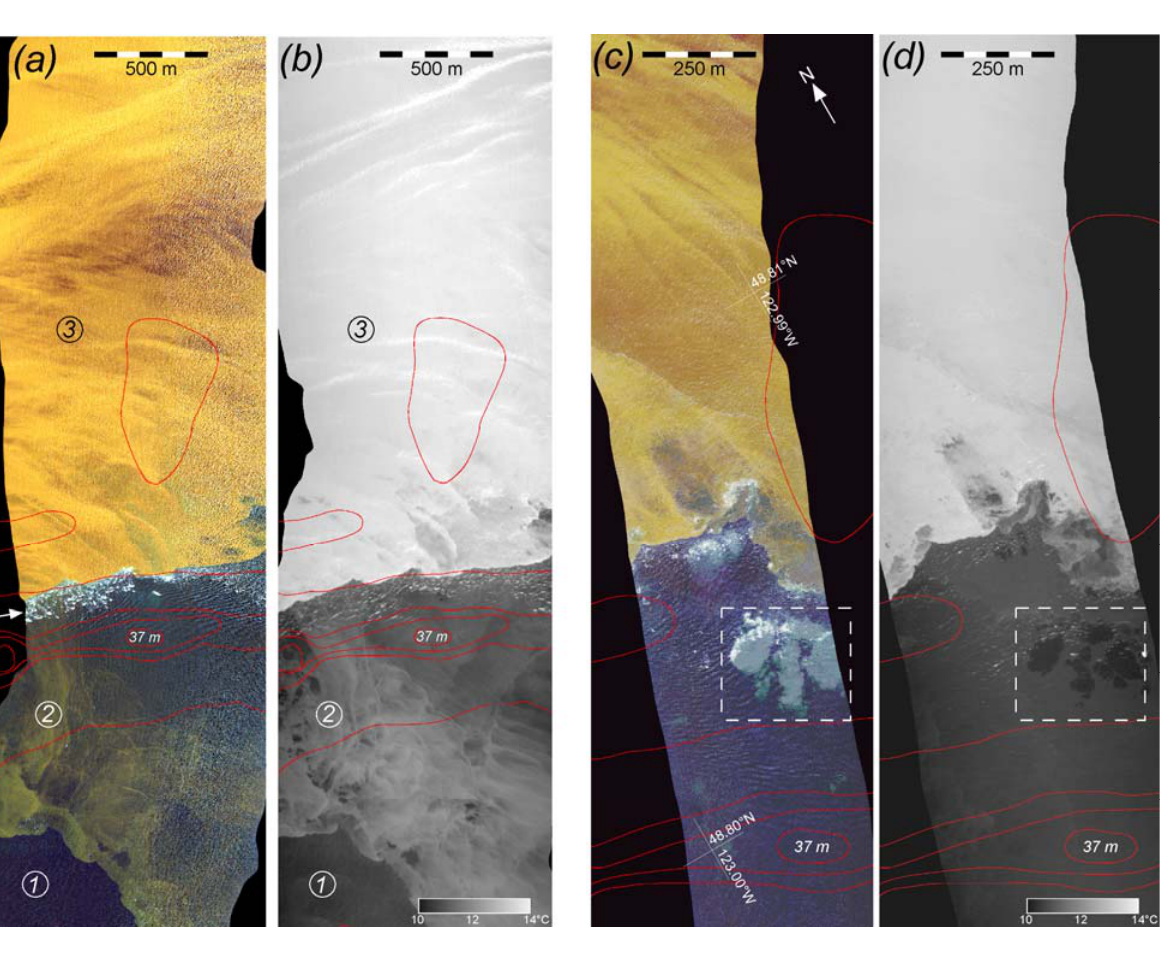
Figure 5. Visible ( a ) and infrared (IR) ( b ) data collected at 1939 UT 23 May 2009